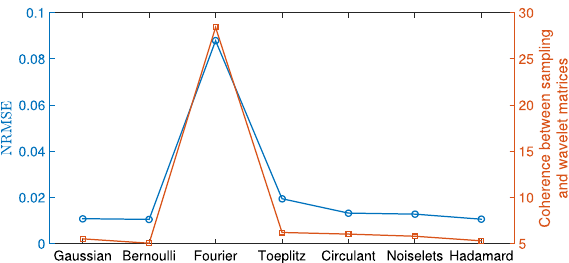
Fig. 7 Plots showing the reconstruction error ( left y -axis, blue line ) and the coherence metric ( right y -axis, red line ) for different sampling matrices ½ U (cid:7) . Results correspond to the StOMP reconstruction of the field f with a compression ratio R ¼ 10. The wavelet bases for reconstruction are Alpert wavelets with an order w ¼ 5